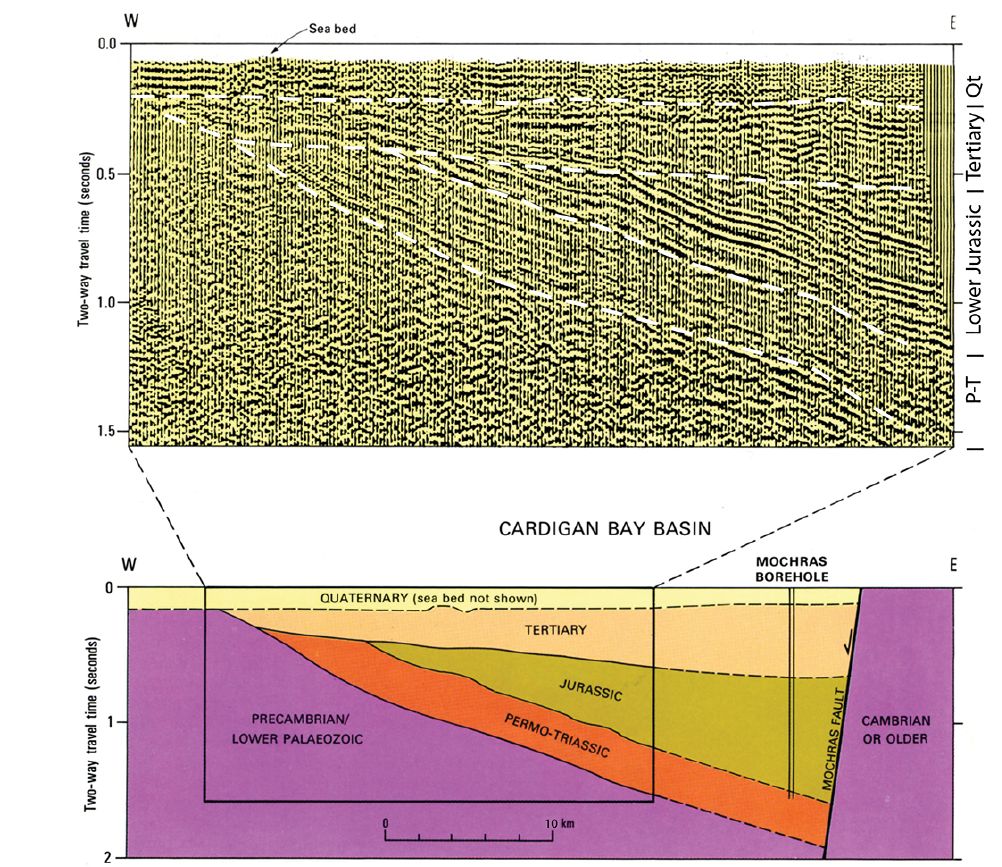
Figure 4. British Geological Survey seismic reflection profile 2B and extended geological interpretation including original Mochras borehole (from Tappin et al., 1994, with minor